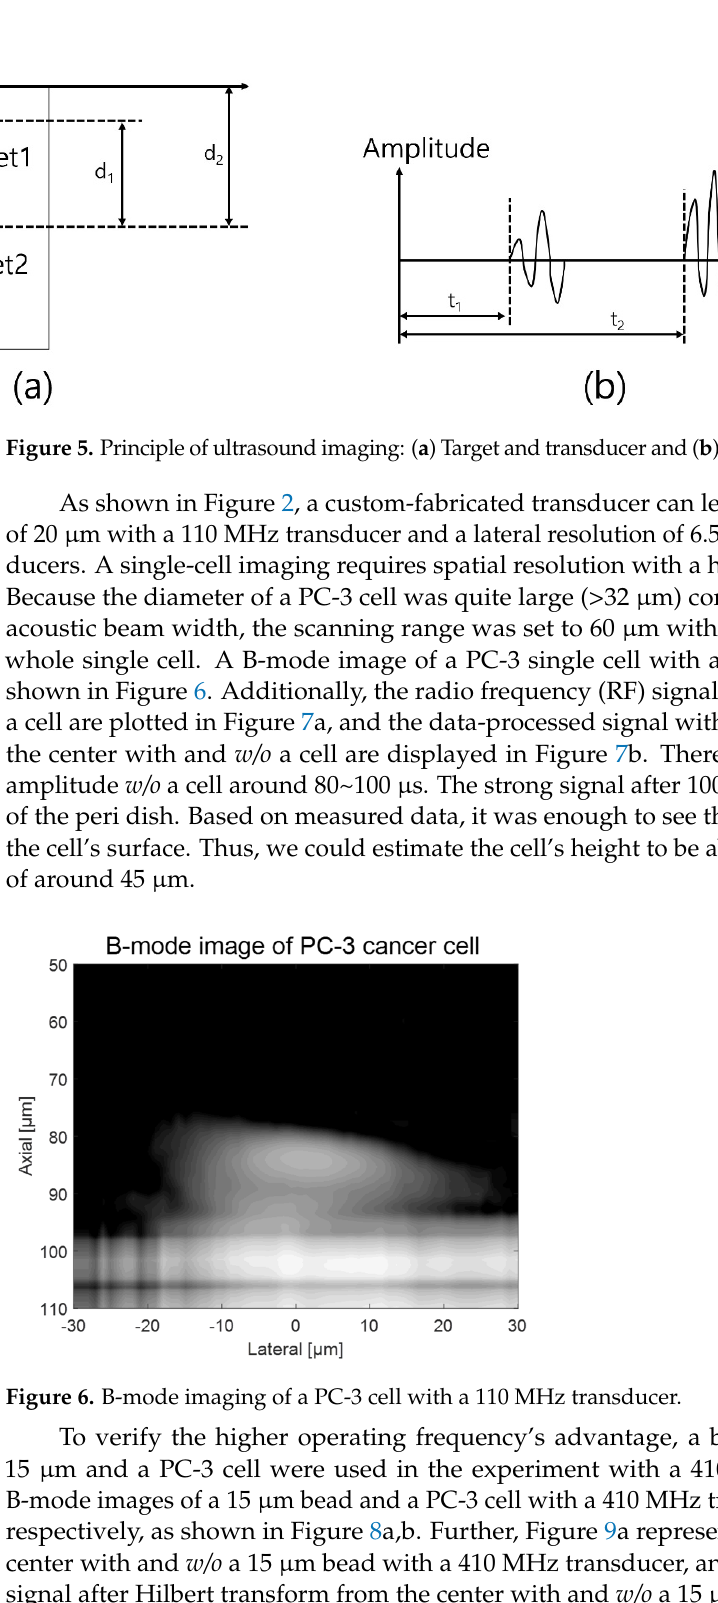
Figure 7. ( a ) Raw signal from the center with and without ( w/o ) a PC-3 cell with a 110 MHz trans- ducer, and ( b ) signal after Hilbert transform from the center with and w/o a PC-3 cell with a 110 MHz transducer. To verify the higher operating frequency’s advantage, a bead with a diameter of 15 μ m and a PC-3 cell were used in the experiment with a 410 MHz transducer. The B-mode images of a 15 μ m bead and a PC-3 cell with a 410 MHz transducer were acquired, respec- tively, as shown in Figure 8a,b. Further, Figure 9a represents raw signals from the center with and w/o a 15 μ m bead with a 410 MHz transducer, and Figure 9b displays the signal after Hilbert transform from the center with and w/o a 15 μ m bead with a 410 MHz trans- ducer. For more detailed analysis of a single-cell imaging, raw signals and the data pro- cessed signals with and w/o a cell were plotted in Figure 9c,d, respectively.